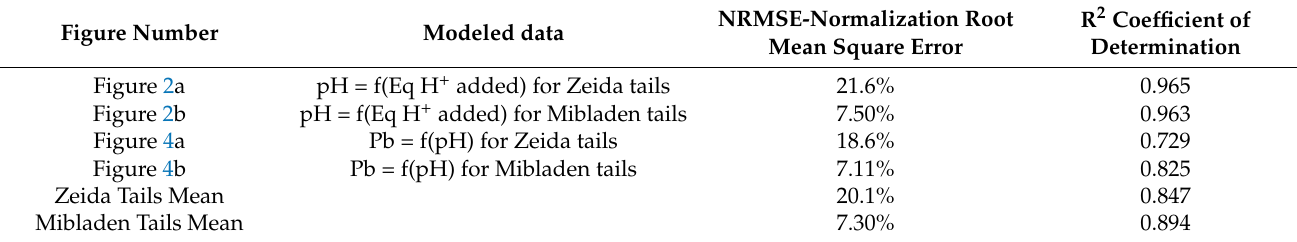
Figure 2. Evolution of the pH as a function of the H + added to the mining waste from Zeida ( a ) and Mibladen ( b ): experimental points (marks, adapted from [1,32])) and geochemical modeling (solid lines indicate the modeling with the gas phase, and the dashed lines indicate the modeling without the gas phase). Table 3. Performance measurement of the final geochemical